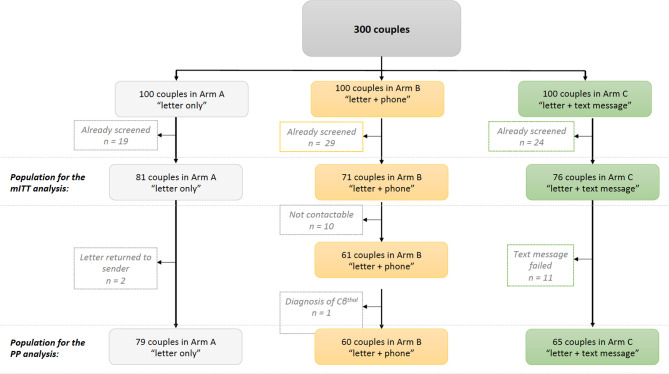
Study flow chart. mITT: modified intention-to-treat; PP: Per protocol.